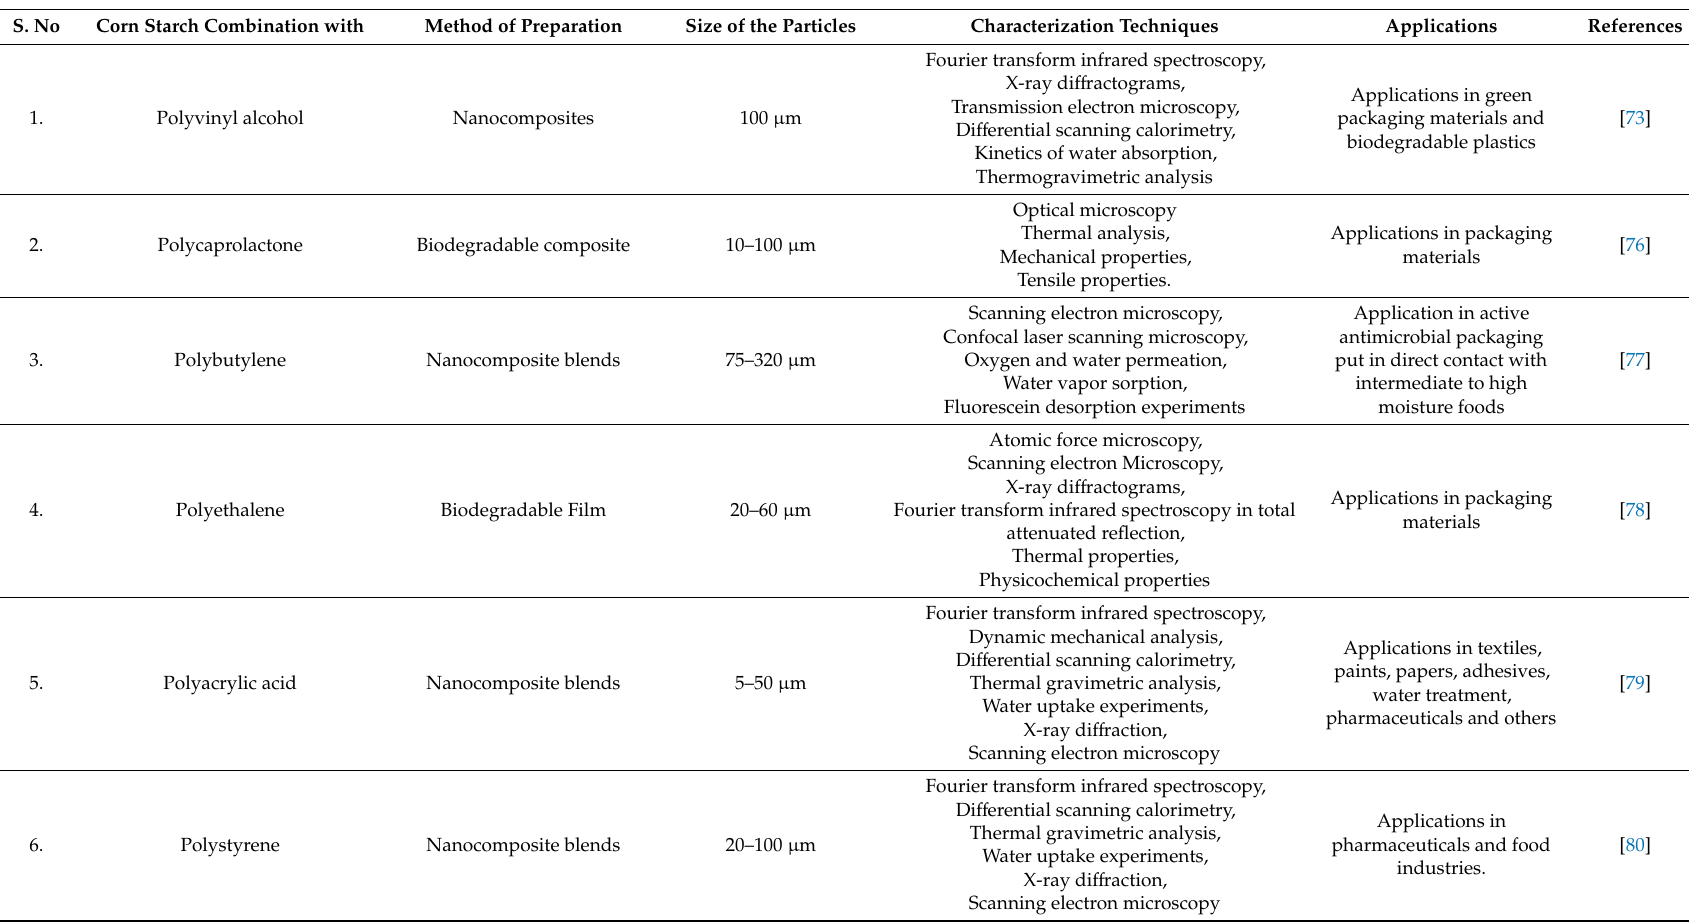
Table 2. Combination of corn starch with synthetic polymers, method of preparation, characterization techniques, and their applications. S.